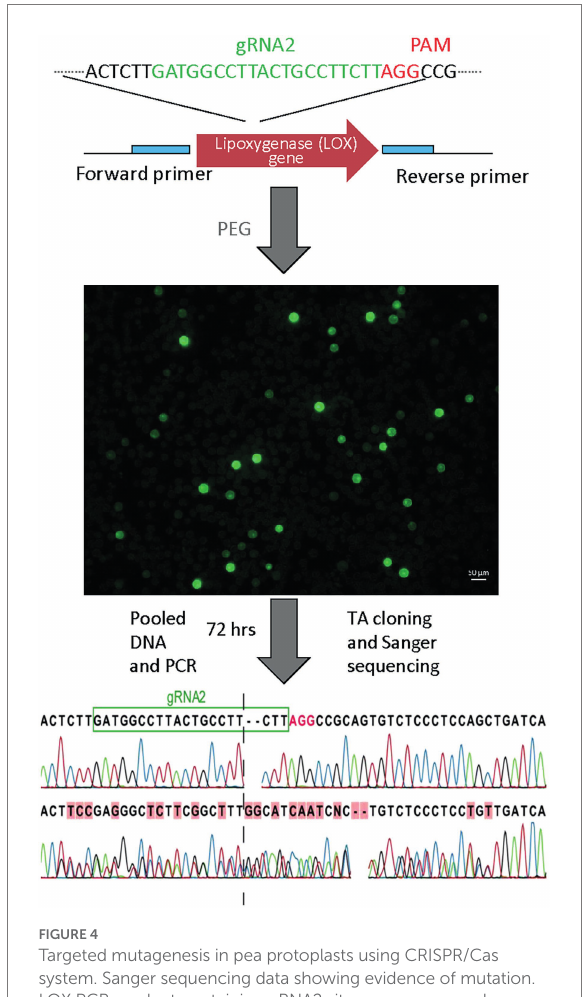
FIGURE 4 Targeted mutagenesis in pea protoplasts using CRISPR/Cas system. Sanger sequencing data showing evidence of mutation. LOX PCR product containing gRNA2 sites was sequenced. Dashed lines represent the DSB site of the